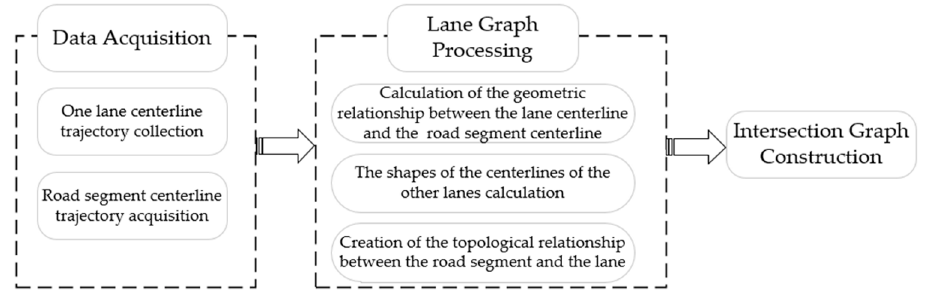
Figure 2. Framework of the geometric-based approach.